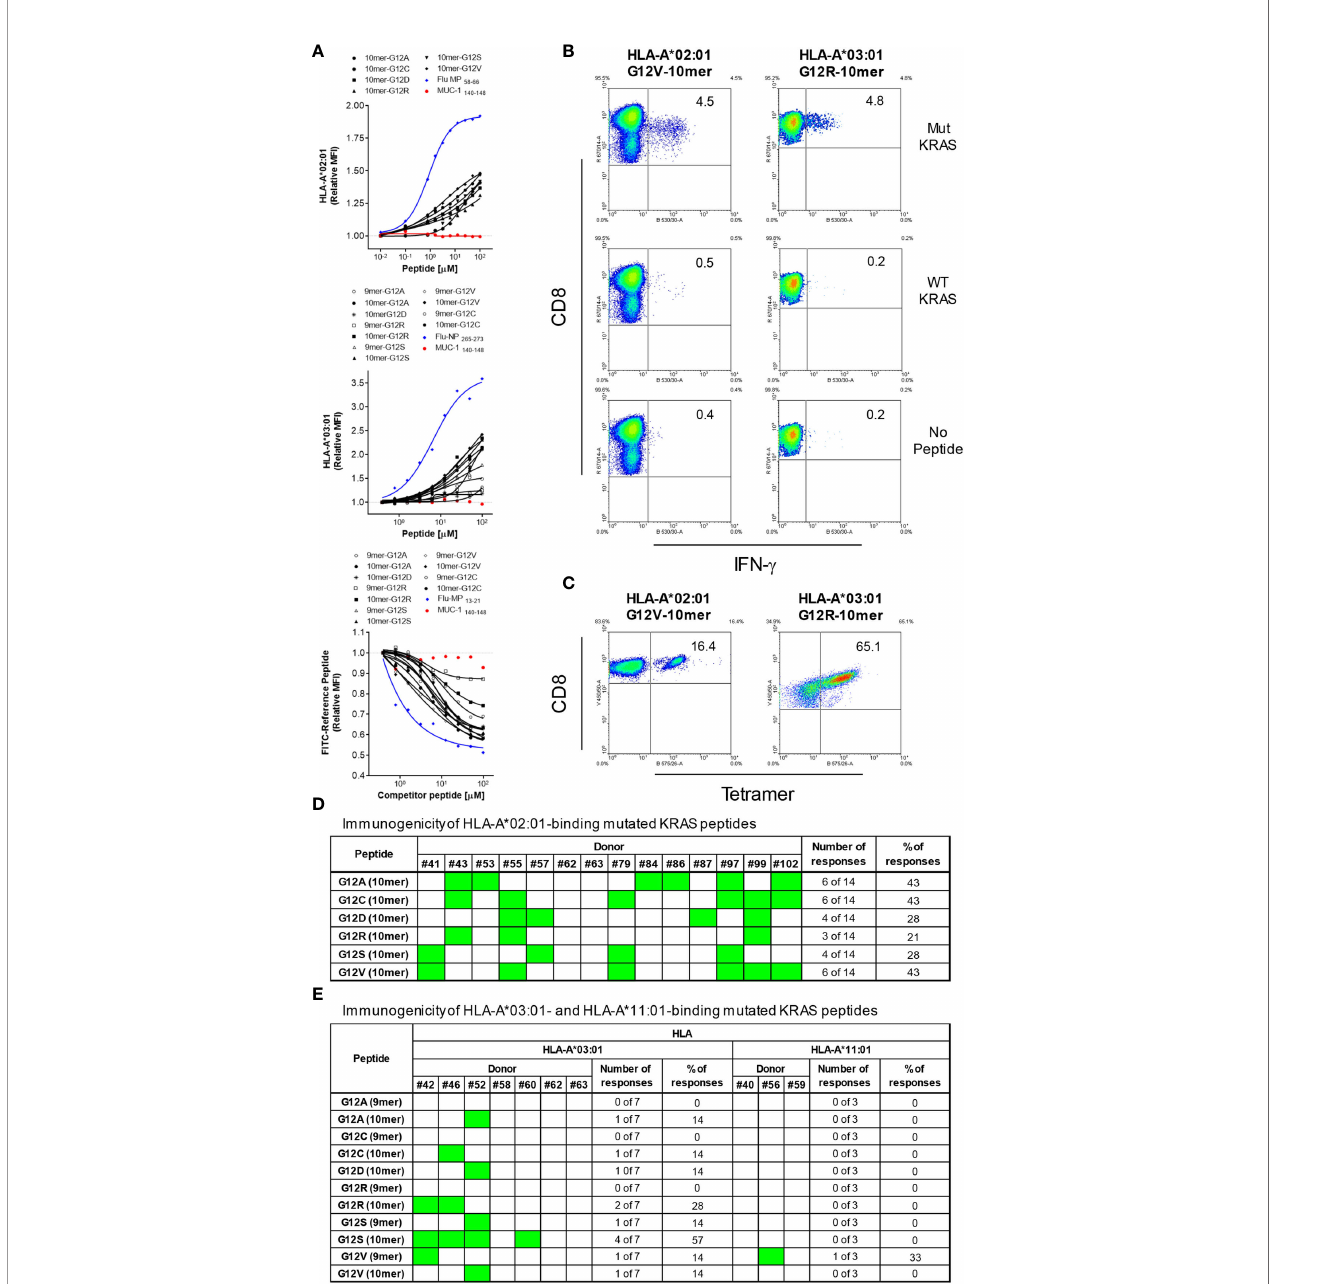
FIGURE 1 | HLA-binding and immunogenicity of RAS-mutant peptides. MHC-I Stabilization assays using TAP-de fi cient T2 cell lines expressing HLA-A*02:01 (A, upper graph ) or HLA-A*03:01 (A, middle graph ) or a competitive MHC-I-binding assay using a lymphoblastoid cell line (CJO-A) expressing HLA-A*11:01 (A, lower graph ) were carried out to assess binding of 9-and 10-mer peptides representing 6 RAS mutants. The binding of each peptide was analyzed three times and the mean of all of the experiments performed is shown. MUC-1 140-148 peptide was used as negative control; as positive control, Flu MP 58-66 and Flu-NP 265-273 peptides were used for HLA-A*02:01 and HLA-A*03:01 respectively; Flu-MP 13-21 peptide was used as positive control for HLA-A*11:01; Flu-MP: In fl uenza virus Matrix Protein; Flu-NP: In fl uenza virus Nucleoprotein. To assess immunogenicity, CD8+ T cells from healthy donors were stimulated four times with autologous peptide-pulsed mature dendritic cells. Seven days after the last round of stimulation, CD8+ T cells were challenged with T2 cells pulsed with the same RAS mutants, WT counterpart or left without peptide. Intracellular IFN- g was measured by FACS. The dot plots in (B) depict the RAS mutations that elicited CD8+ T cell response to a 10-mer peptide containing the G12V and G12R mutation from one representative donor expressing HLA-A*02:01 and HLA-A*03:01, respectively. CD8+ T cells from some responders were further stimulated and expanded and stained with tetramers. A representative experiment is show in (C) . The response from all 14 HLA-A*02:01-positive donors tested is shown in (D) . In (E) is shown the responses from 7 and 3 HLA-A*03:01- and HLA-A*11:01-positive donors, respectively; responses are shown in green. It is noteworthy that the CD8+ T cells reactive to the mutant RAS did not respond to the non-mutated